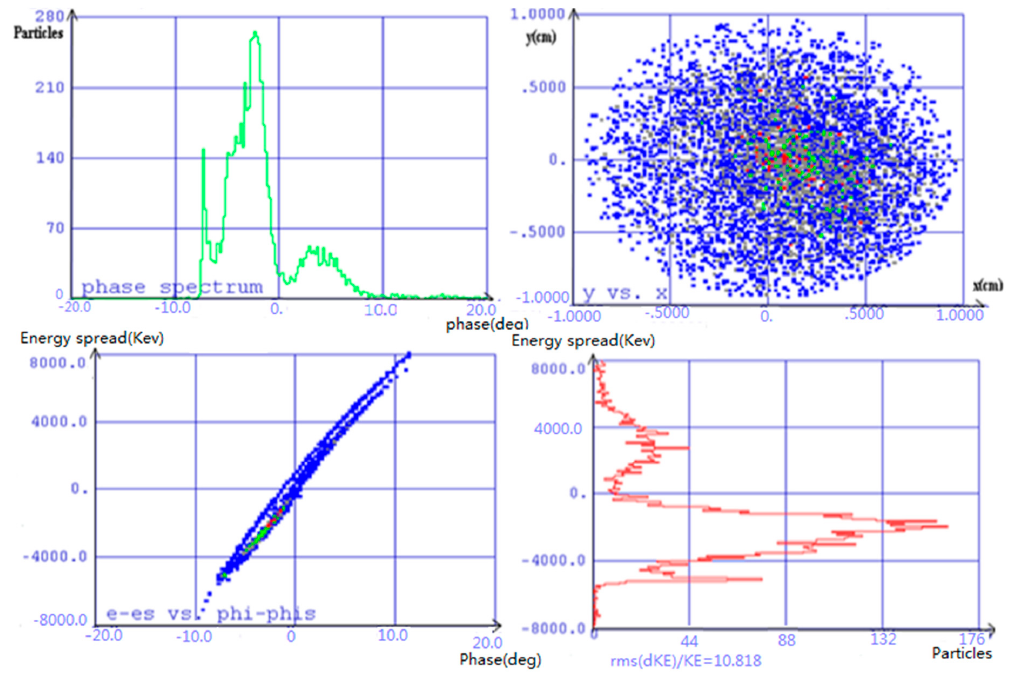
Figure 8. Beam parameters at A0 exit with 30 ps longitudinal jitter.